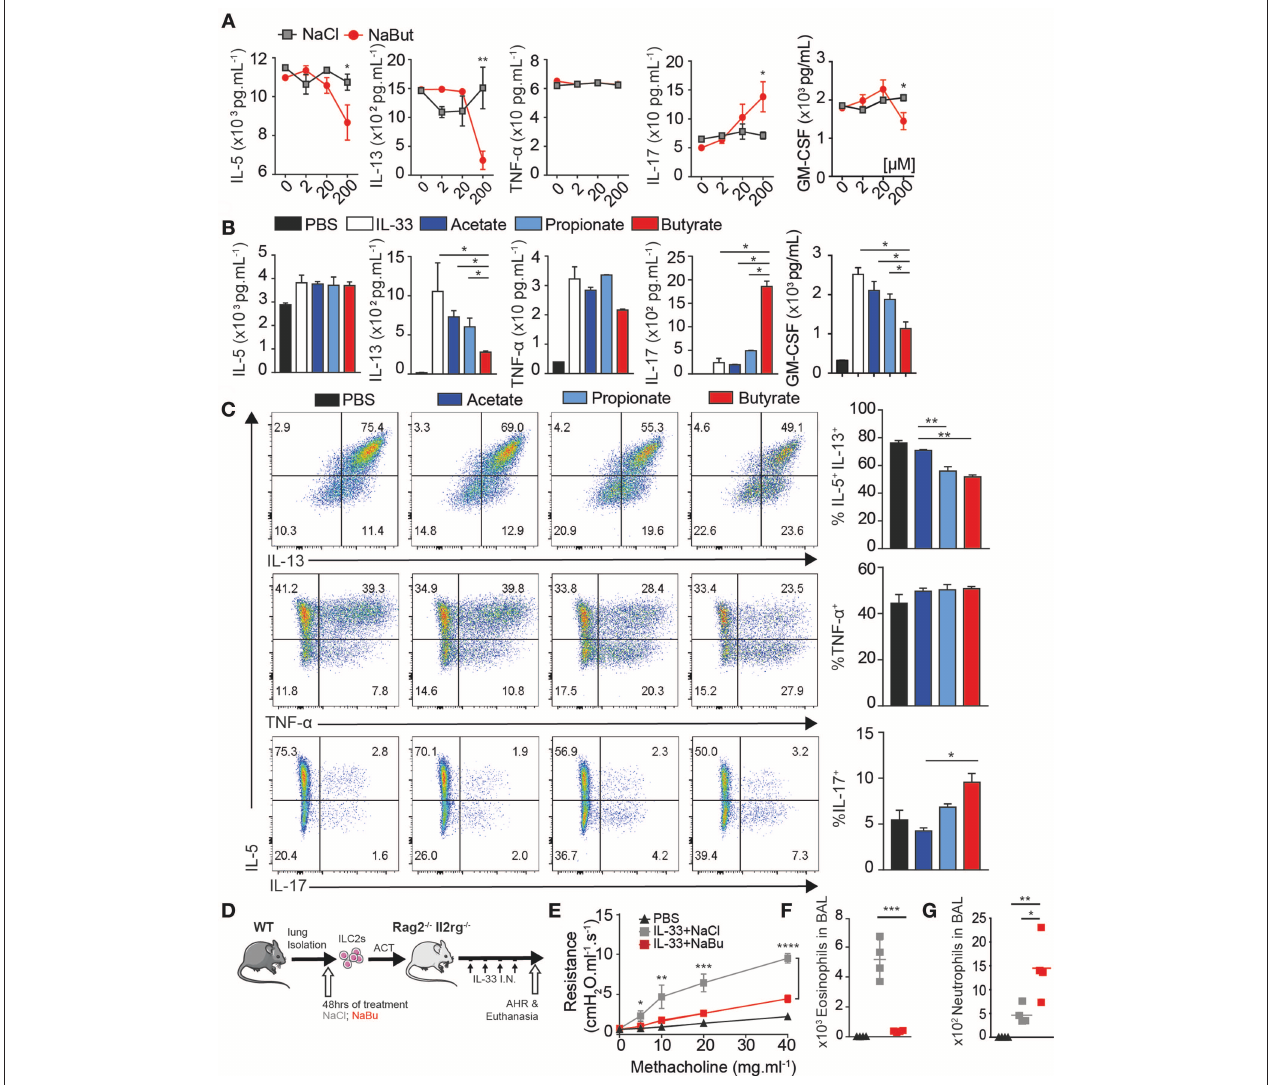
FIGURE 2 | Butyrate suppresses ILC2 function in-vitro and in-vivo . ILC2s were FACS purified from lungs of mice with or without 3 days 0.5 ug IL-33 administration i.n. as indicated and 5 × 10 3 cells/well-cultured ex-vivo for 2–3 days in the presence of IL-2 and IL-7, indicated salt at 2–200 uM and 10ng/mL IL-33. (A) Schematic. (B) Dose dependence of ILC2 suppression by Sodium Butyrate compared to Sodium Chloride. (C) IL-5, IL-13, TNF- α , and IL-17a secretion in supernatant by activated ILC2 measured by Luminex after SCFA treatment at 200 uM. (D) Cytokine production by flow cytometry after 5h stimulation with PMA/Ionomycin/BFA, comparing IL-5 and IL-13 (upper row), TNF- α (middle), or IL-17a in activated ILC2 after 3 days in-vitro . (E) Schematic, 5 × 10 4 ILC2 treated with 200 uM NaCl or Butyrate, washed, transferred i.v. into RAG − / − γ C − / − mice challenged and with 3 days IL-33 i.n. (F) Lung resistance (AHR) upon increasing methacholine challenge. (G) Total Eosinophils in BAL. Total Neutrophil count in BAL. (A–D) Data are graphed as duplicate wells + -SEM, representative of three independent experiments and (E–G) two independent experiments, n = 4–5 mice/group + -SEM. * p < 0.05, ** p < 0.01, *** p < 0.001, and **** p < 0.0001.